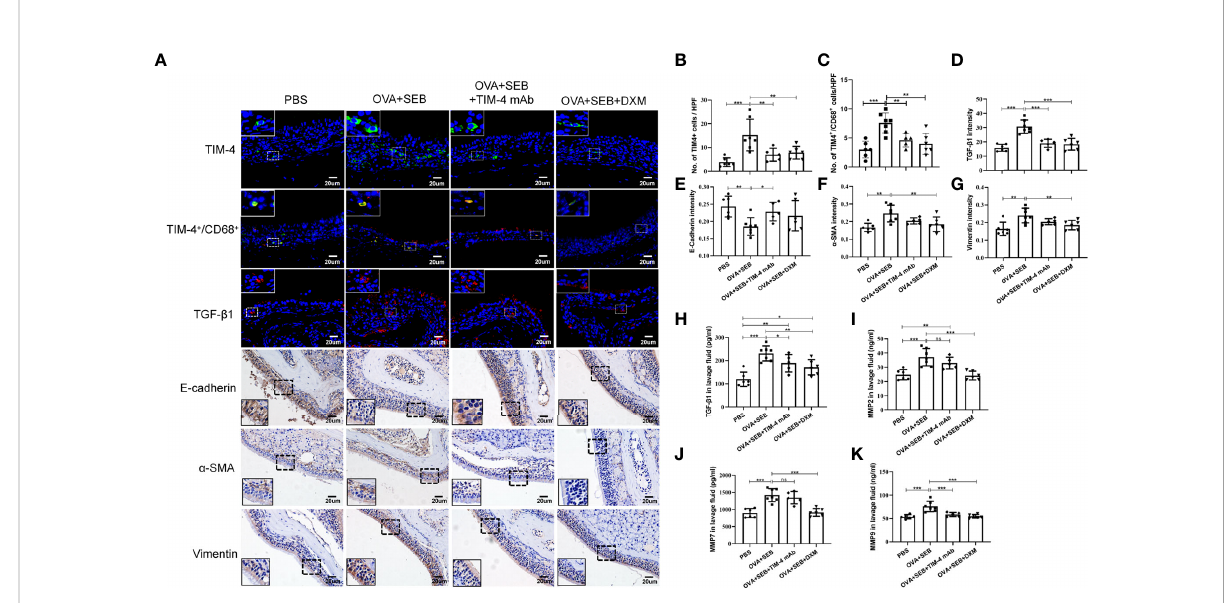
FIGURE 4 TIM-4 interference inhibits the EMT process in the NP model. (A) TIM-4 + cells (green), TIM-4 + /CD68 + cells (yellow), and TGF- b 1 (red) in the mouse sinonasal mucosa were detected by immuno fl uorescence. E-cadherin, a -SMA, and Vimentin in the mouse sinonasal mucosa were detected by IHC. (B) Quantitative summary of the number of TIM-4 + cells in the mouse sinonasal mucosa. (C) Quantitative summary of the number of TIM-4 + /CD68 + cells in the mouse sinonasal mucosa. (D) Quantitative summary of the intensity of TGF- b 1 in the mouse sinonasal mucosa. (E) Quantitative summary of the intensity of E-cadherin in the mouse sinonasal mucosa. (F) Quantitative summary of the intensity of a - SMA in the mouse sinonasal mucosa. (G) Quantitative summary of the intensity of Vimentin in the mouse sinonasal mucosa. (H-K) The TGF- b 1, MMP2, MMP7, and MMP9 levels in the nasal lavage fl uid were detected by ELISA. PBS group: n=6; OVA+SEB group: n=7; OVA+SEB+TIM-4 mAb group: n=5; OVA+SEB+DXM group: n=6. IHC and immuno fl uorescence representative pictures are shown at a magni fi cation of 400×. The insets show a higher magni fi cation of the selected area. Bars show the mean ± SD. *P<0.05, **P<0.01,***P<0.001. ns, no signi fi